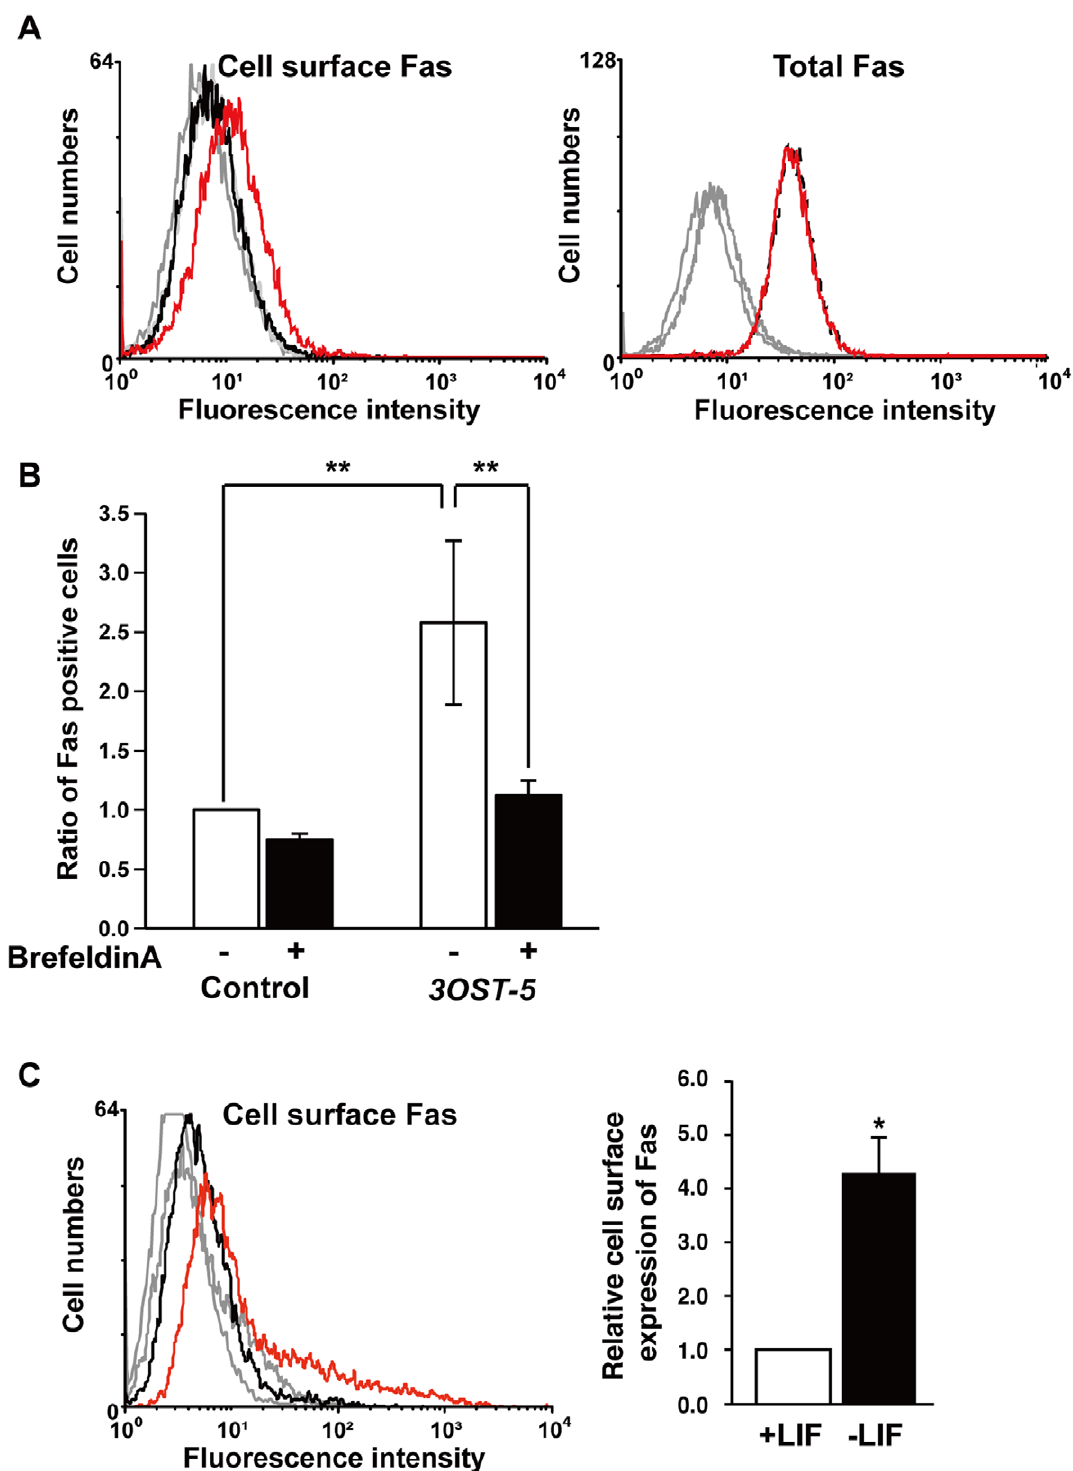
Figure 3. The expression of Fas increased on the surface of cells overexpressing 3OST-5 . (A) FACS analysis of cell surface Fas ( left panel) or total Fas ( right panel ) in cells overexpressing 3OST-5 using an anti-Fas antibody ( black line , control cells; red line , cells overexpressing 3OST-5 ). The gray line shows the result obtained from cells not treated with primary antibody. As described in Materials and Methods, mESCs were permeabilized to observe total Fas expression or not permeabilized to observe Fas expression on the cell surface. (B) FACS analysis, using an anti-Fas antibody, of Fas on the surface of cells that were overexpressing 3OST-5 and had been treated with brefeldin A. The histograms show the ratio of the mean fluorescence intensity of the treated cells to that of non-treated control cells (arbitrary value=1). Values are the means 6 SD. (C) FACS analysis of cell surface Fas in mESCs cultured for 8 days in the absence of LIF using an anti-Fas antibody. In the left panel , a histogram shows a representative result of the FACS analysis ( black line , in the presence of LIF; red line , in the absence of LIF). The gray line shows the result obtained from cells not treated